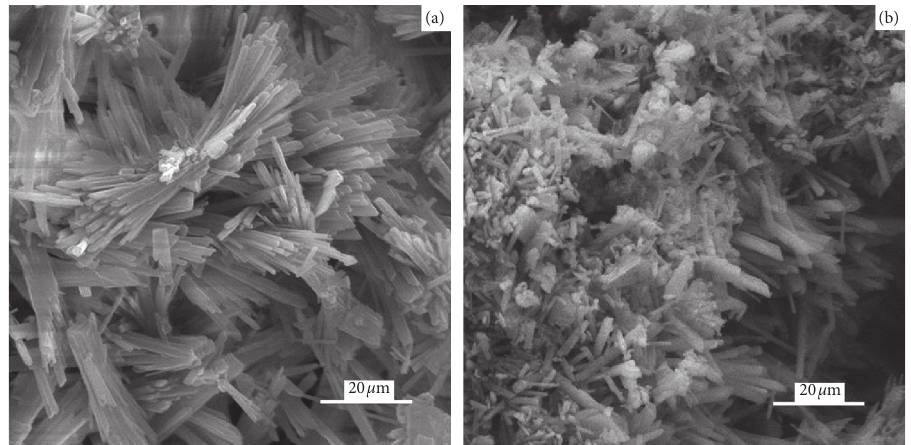
Figure 10: Microstructure of hardened RP (a) and hardened RAP